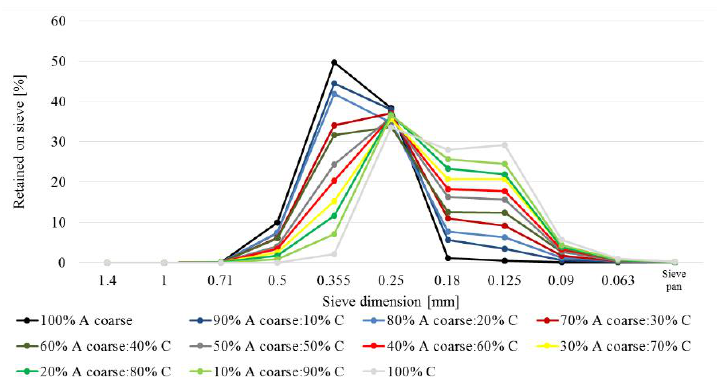
Figure 9. Grain size distribution curves for sands A coarse and C. Table 4. Basic properties of sands A coarse and C.